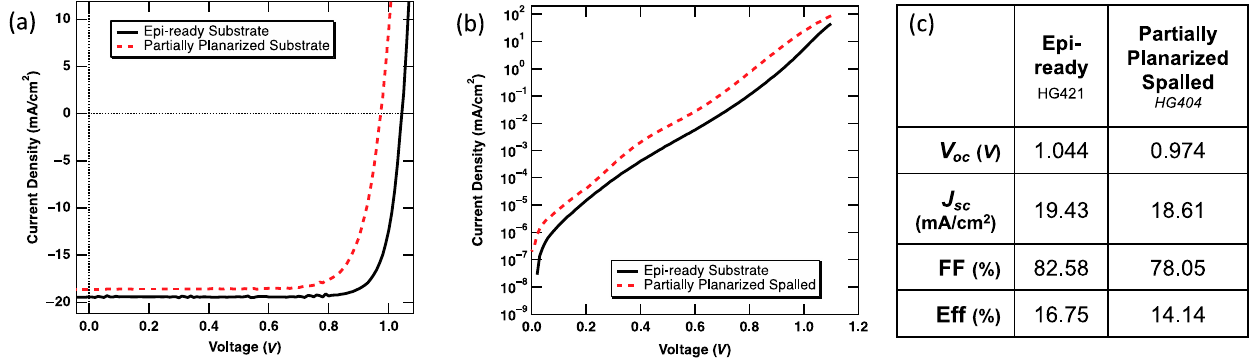
Figure 4. ( a ) Illuminated and ( b ) dark J-V curves with ( c ) extracted metrics for GaAs solar cells